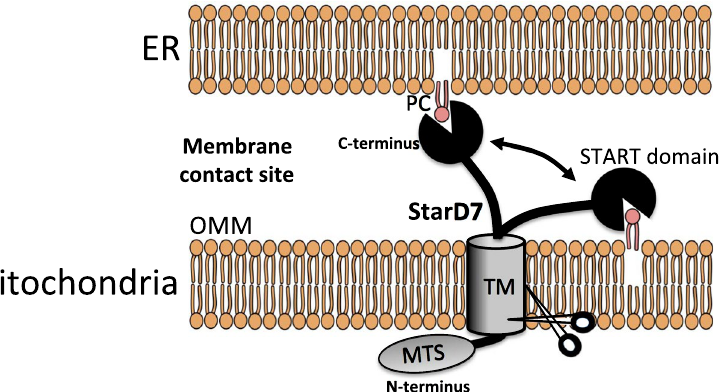
Figure 8. Scheme for the localization and function of StarD7 in the OMM. StarD7 is anchored in the OMM via its TM domain and extends its C-terminal START domain into the cytoplasm. At ER-mitochondria contact sites, the ER membrane comes close to the mitochondrial membrane through the action of tethering proteins. StarD7 may exchange/shuttle PC between the outer leaflet of the ER membrane and the outer leaflet of the OMM at the organelle contact sites. The scissors indicate a mitochondrial peptidase that cleaves the peptide bonds between Met 76 and Ala 77 , and Ala 77 and Ala 78 within the TM domain to produce the mature form of the